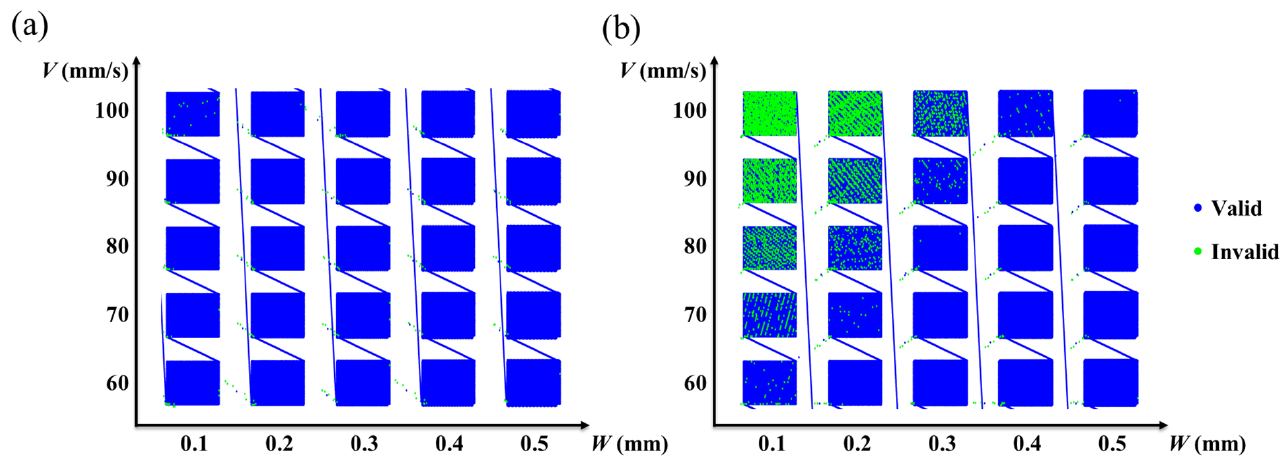
Figure 4. Reliable parameter judgment results ( a ) OL: 50% ( b ) OL: 66%.